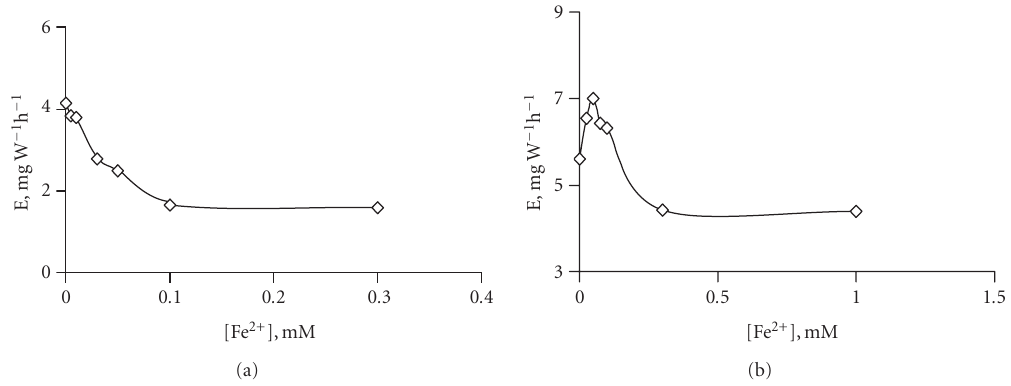
Figure 5: The e ffi ciency of PCO of (a) humic acids, 10 mg L − 1 , and (b) lignin, 100 mg L − 1 , with TiO 2 attached to the glass plate, 0.7 mg cm − 2 ; pH 3; treatment time